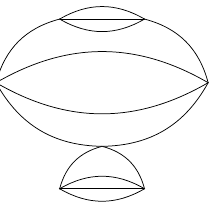
Figure 2 . A melon tadpole graph, where all the invariants have been shrunk to point-like vertices. of the propagator: the free theory is unitary for any (cid:16) quartic invariants marginal in any d